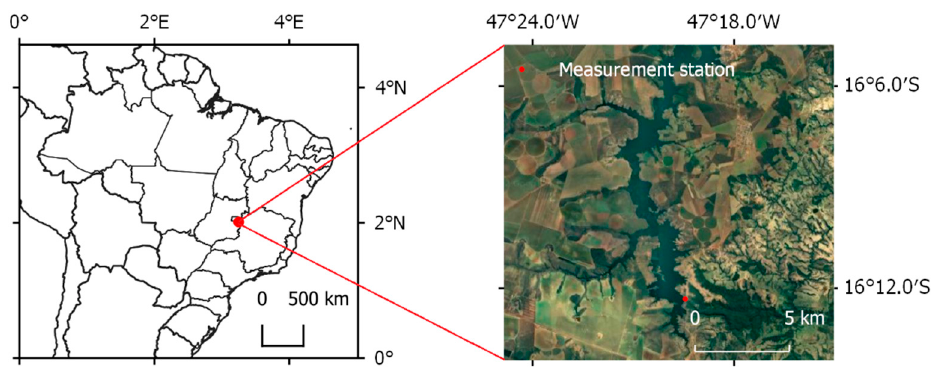
Figure 1. Map showing measurement station location in central Brazil.